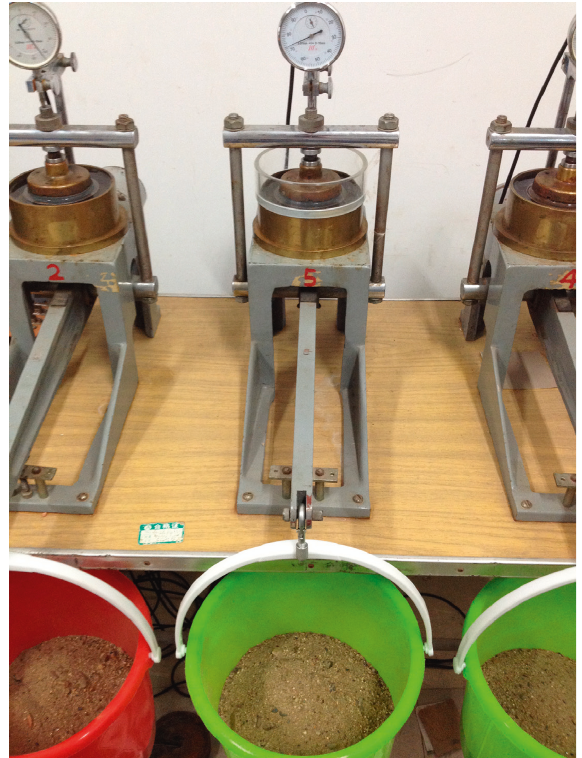
Figure 5: Oedometer apparatus for the